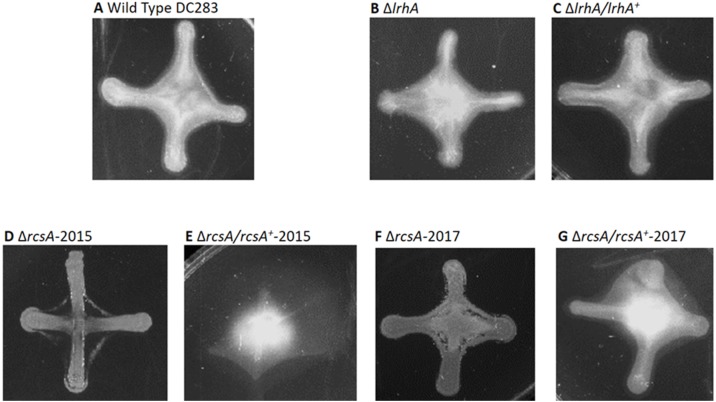
Impact of RcsA and LrhA on capsule production of P. stewartii.All pictures were taken at the same magnification after two days of incubation at 30 °C after cross-streaking on casamino acid, peptone, glucose (CPG) agar plates. Differences in capsule production are apparent in the regions between the arms of the X-cross streak.